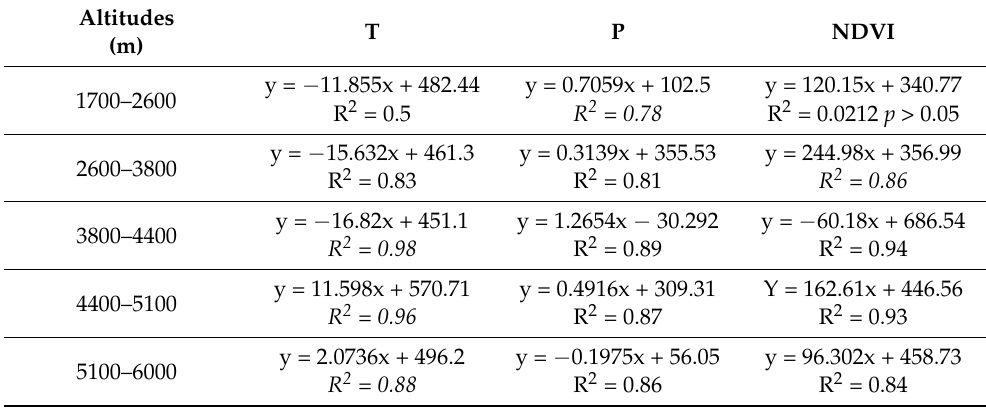
Table 4. Correlation between ET and T, P, NDVI at different altitude gradients ( p < 0.01).